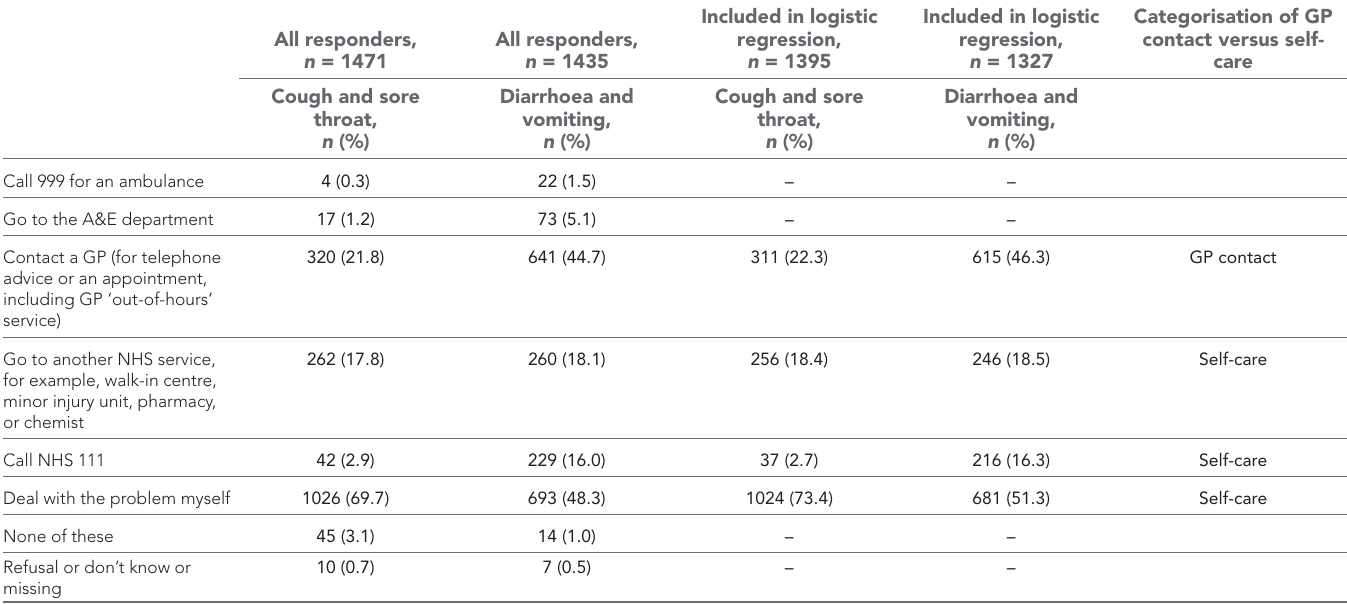
Table 3 Percentages of sample selecting options for minor illness vignettes.